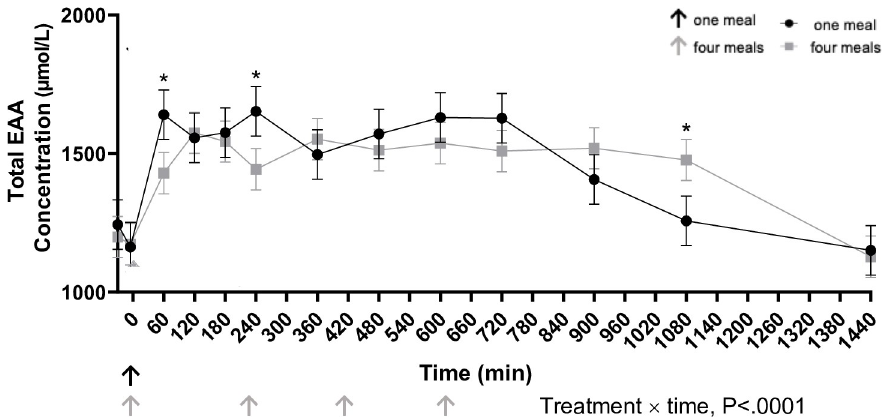
Fig 5. Total plasma essential amino acid concentration ( μ mol/L) in cats eating a canned diet once (0800h) or four (0800h, 1130h, 1500h, and 1830h) times daily over 24 hours (n = 8 but with 11 experimental periods). Values are expressed as LSM ± SEM. � = P < 0.05